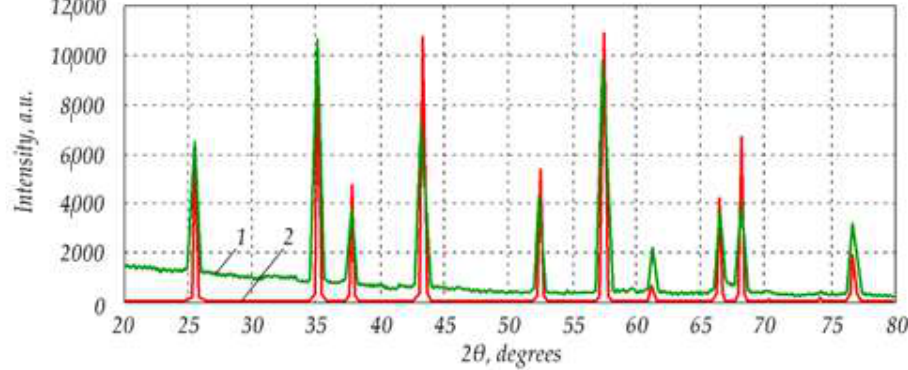
Figure 4. XRD analysis of nanopowders: 1—analysed Al 2 O 3 powder; 2—standard α–Al 2 O 3 phase. Nanopowders SiO 2 delivered by Guandzou Hongwu Material Technology Co. Ltd. (Guangzhou, China) were used for preparation of Al 2 O 3 –SiO 2 –ZrO 2 powders mixture. Their morphology can be seen in Figure 5.